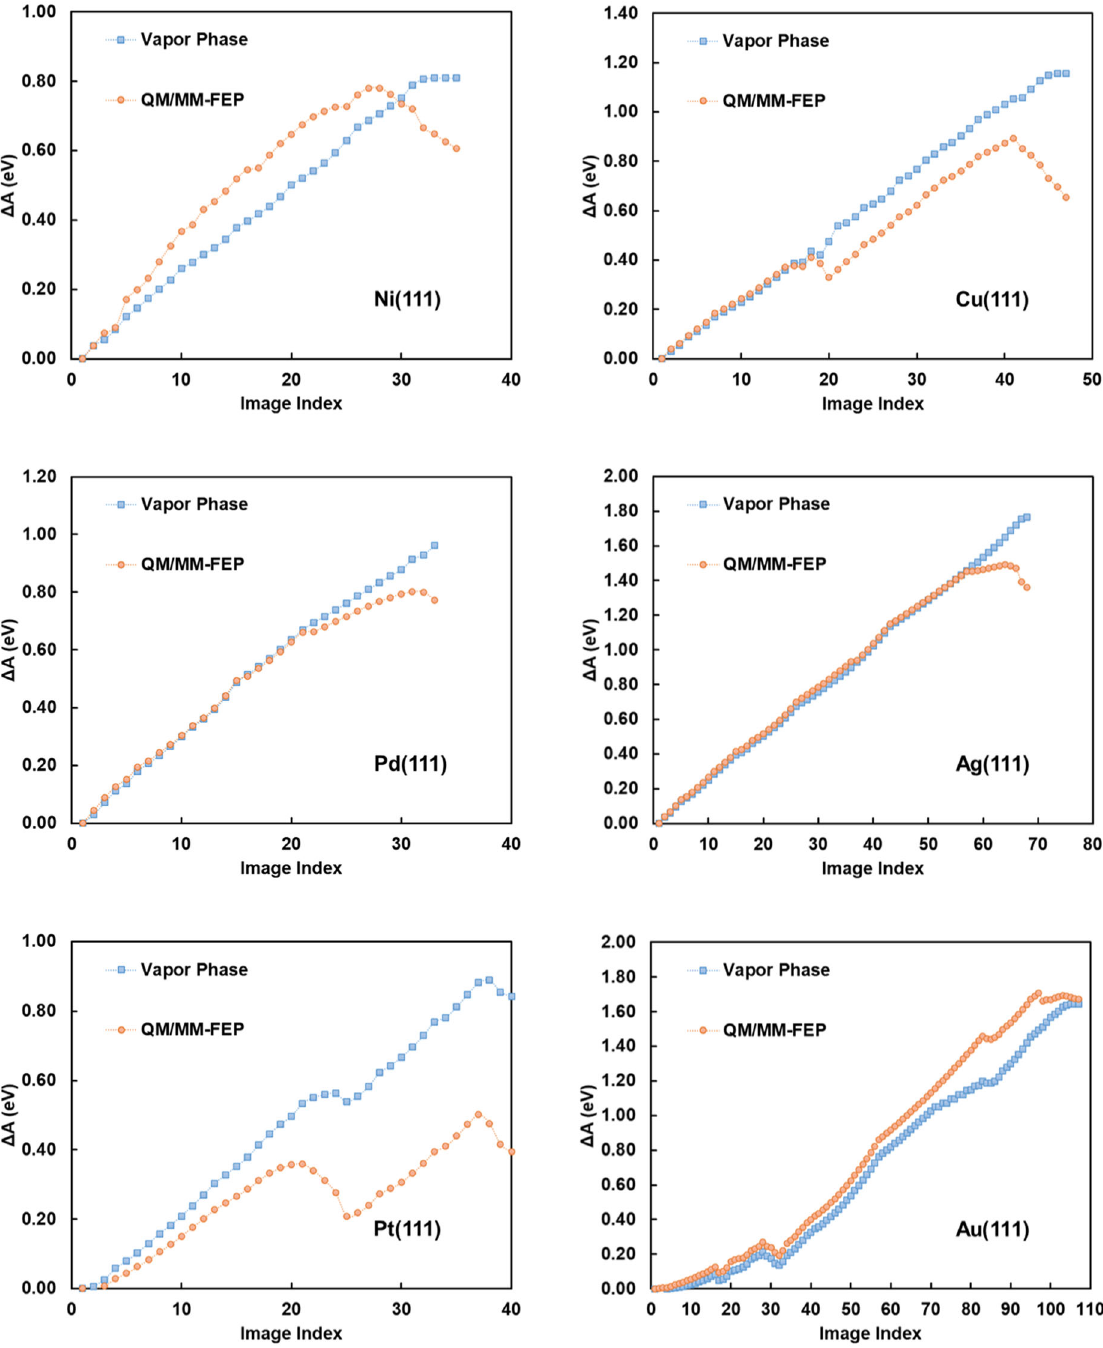
Fig. 2 Free-energy pro fi les for O – H bond cleavage of ethylene glycol at 423 K. The pro fi les are for vapor and aqueous phase over the (111) surface facets of six transition metals without considering vibrational contributions to the partition functions. See Table 1 for corresponding data that include vibrational contributions. The number of intermediate states between the reactant and transition states for eSMS calculations is determined by our desire to have an energy difference between intermediate states smaller than twice the thermal energy (<2 k B T ). The aqueous-phase pro fi les portray the average of three or more independent eSMS calculations possessing 95% con fi dence intervals smaller than ±0.05 eV (see Table 1). The analogous plot for C – H bond cleavage reaction is provided in the Supplementary Fig.